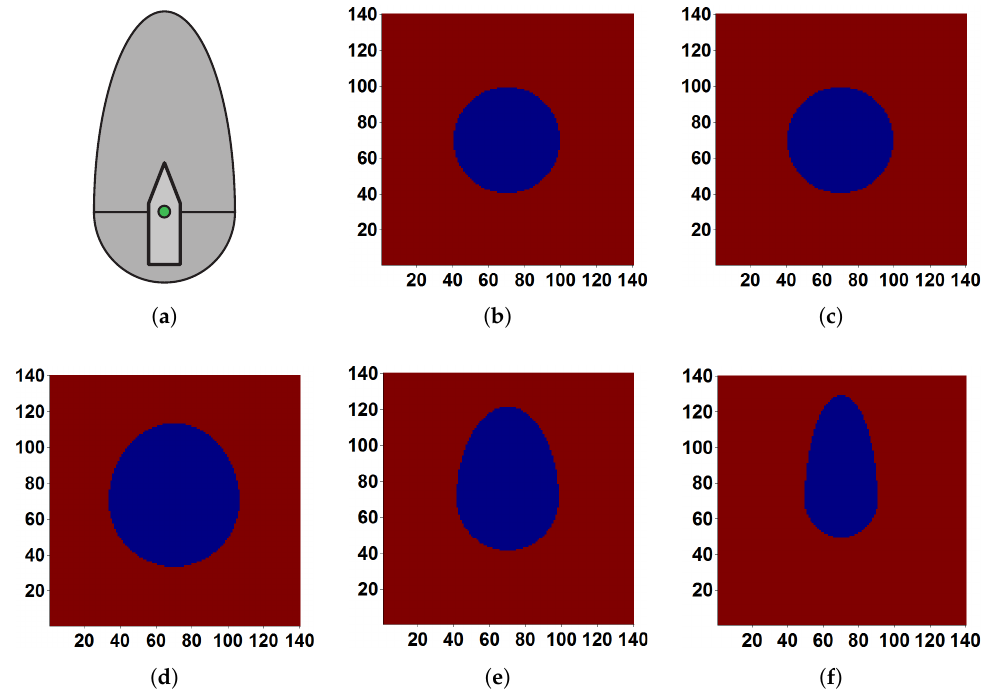
Figure 13. Target vessel dynamic domain model. ( a ) Schematic of the target vessel dynamic domain model; ( b ) The pixel image of domain model with speed 2.5 m/s; ( c ) Speed 5 m/s; ( d ) Speed 6 m/s; ( e ) Speed 8 m/s; ( f ) Speed 10 m/s.